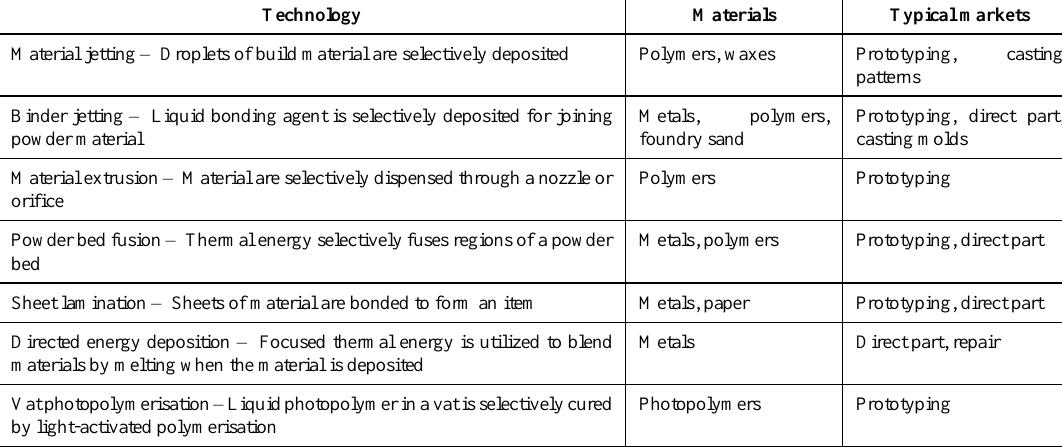
Table 6. Essential categories of 3D